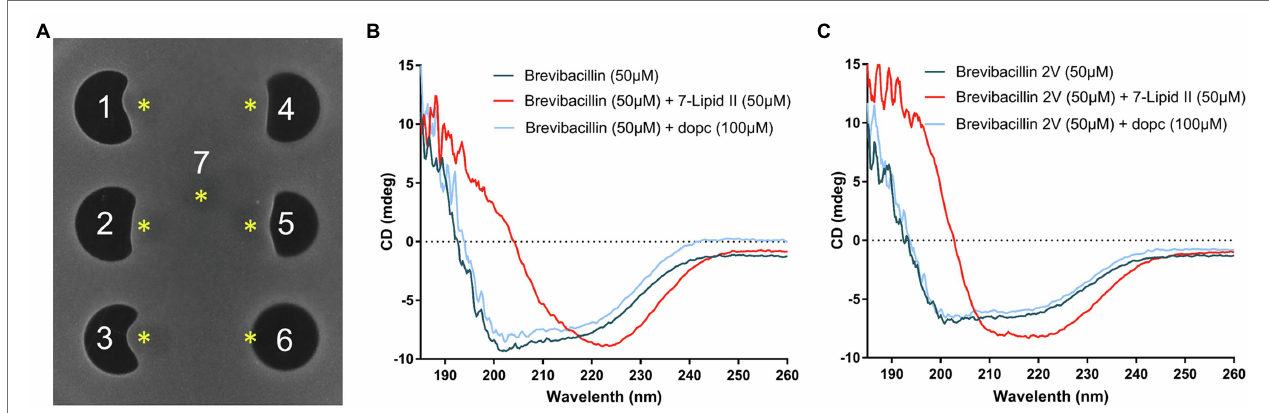
FIGURE 4 | Brevibacillins bind to the cell wall synthesis precursor Lipid II. (A) , Spot-on-lawn assay with S. aureus (MRSA). 1, brevibacillin; 2, brevibacillin V; 3, brevibacillin I; 4, brevibacillin 2V; 5, nisin; 6, daptomycin; and 7, MQ. Brevibacillins were added at a concentration of 100 μ g/ml and with a volume of 6.8 μ l; nisin and daptomycin were added at a concentration of 200 μ g/ml and with a volume of 6.8 μ l. * , The position of Lipid II added (300 μ m, 4 μ l). (B) , CD spectrum of brevibacillin, brevibacillin plus 7-Lipid II, and brevibacillin plus DOPC. (C) , CD spectrum of brevibacillin 2V, brevibacillin 2V plus 7-Lipid II, and brevibacillin 2V plus DOPC.